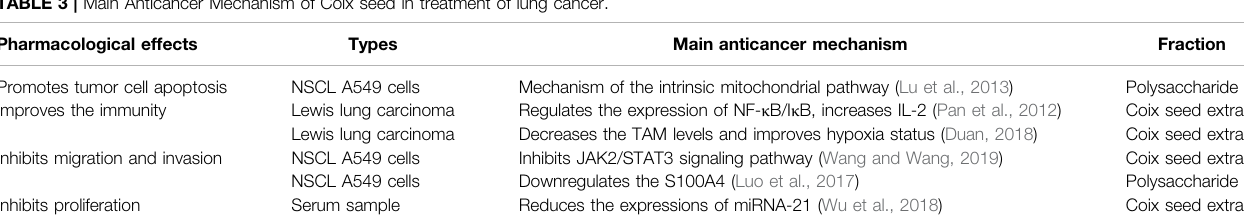
TABLE 3 | Main Anticancer Mechanism of Coix seed in treatment of lung